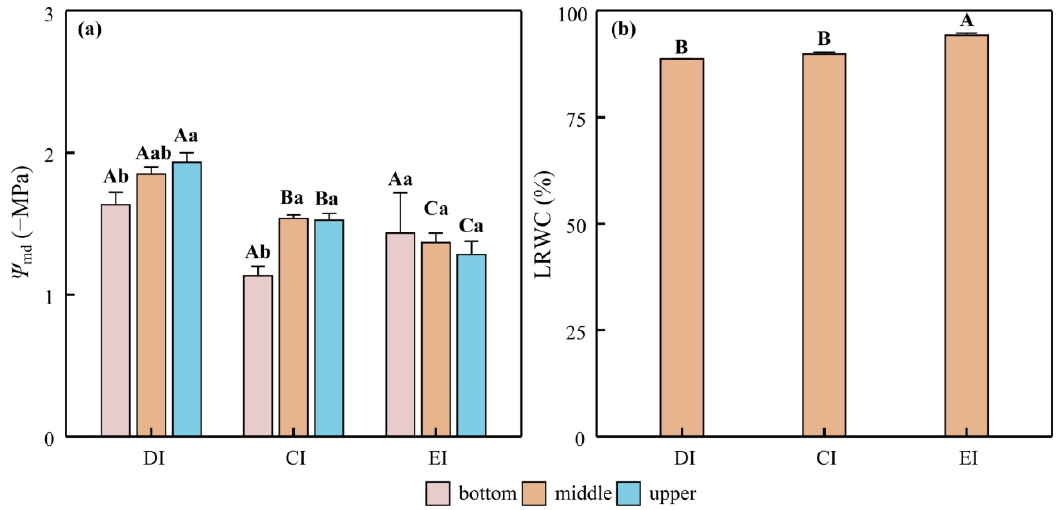
Figure 2. Midday leaf water potential ( Ψ md , ( a )) and leaf relative water content (LRWC, ( b )) of ‘Win 185’ walnuts under different irrigation levels. Different lowercase letters indicate significant differences between different tree heights under the same treatment; Different capital letters indicate significant differences between different treatments at the same tree height ( p < 0.05, mean ± standard error, n = 3~4).